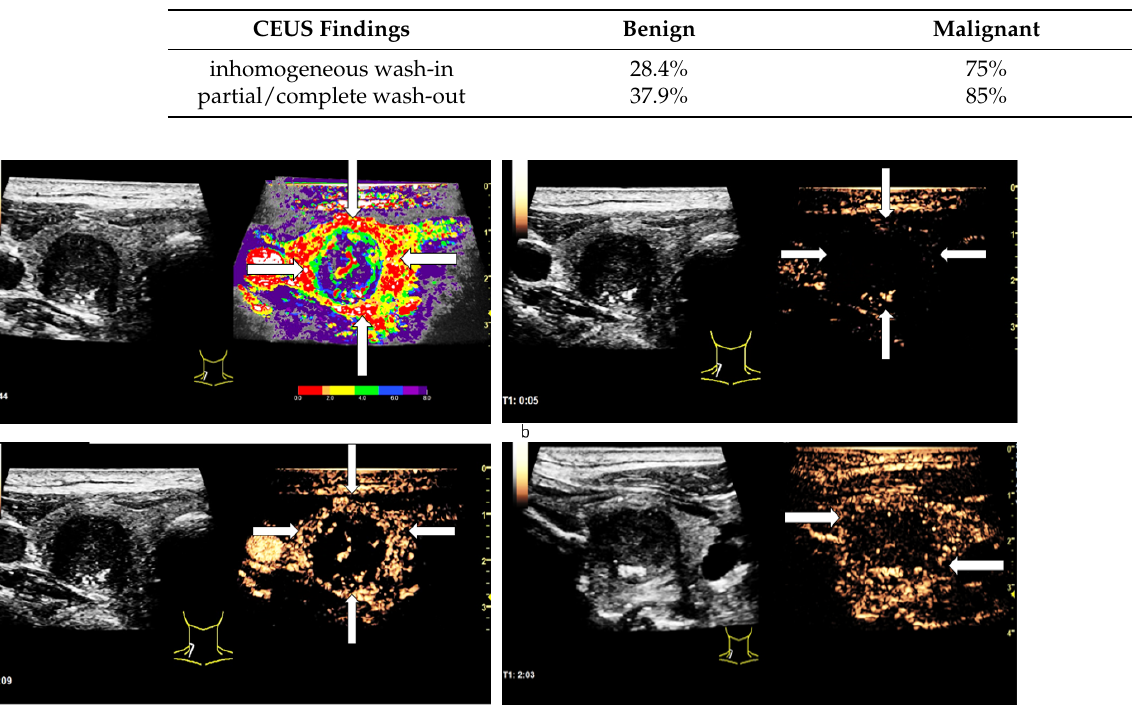
Table 4. Frequency of malignant CEUS findings in benign and malignant thyroid nodules.